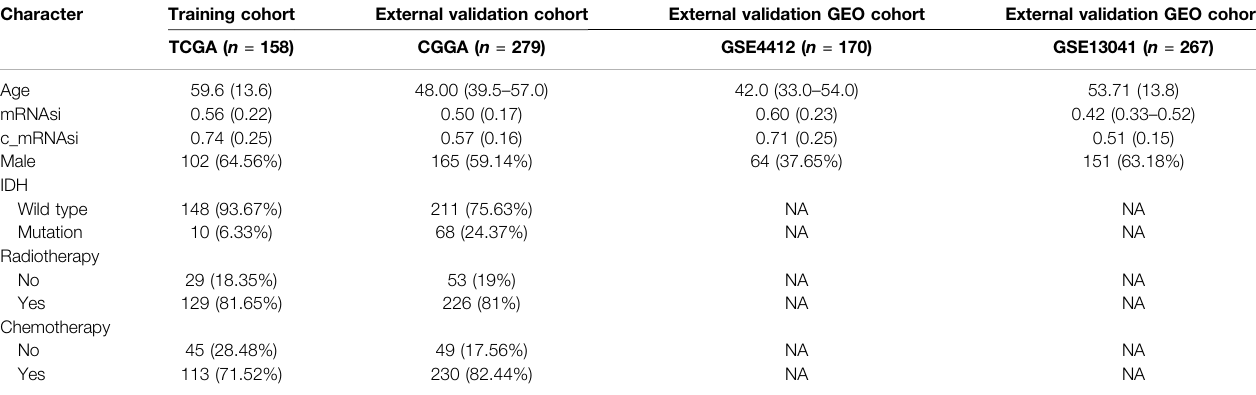
TABLE 1 | Patient